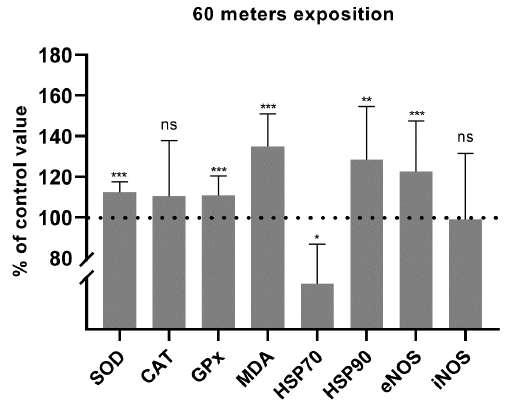
Figure 3. Percentage changes in SOD, CAT and GPx activities and in MDA, HSP70, HSP90, and eNOS concentrations after 60 m exposure (* p < 0.05, ** p < 0.01, *** p < 0.001, ns = p > 0.05).